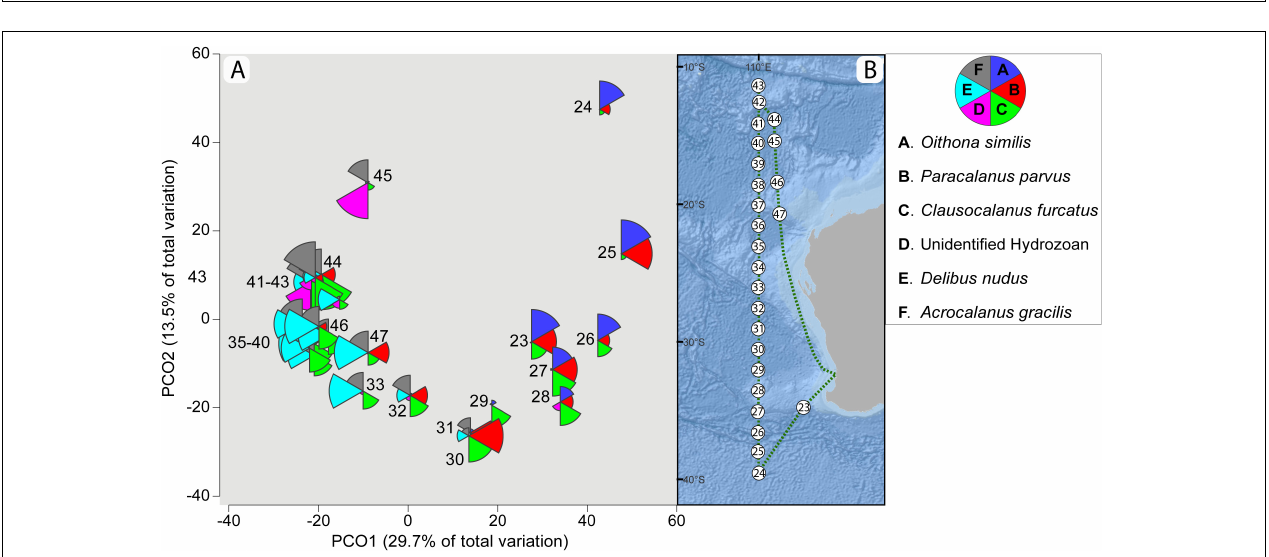
FIGURE 6 | Principal Coordinate Ordination (PCO) based on Bray Curtis similarities of square root transformed plankton (18S rRNA gene) metabarcoding data along a latitudinal transect in the Indian Ocean investigated during the Australian case study (A) with the corresponding sampling station numbers (23–47) as described in Table 1 and Figure 2 . (B) The color pie charts represent the relative prevalence [i.e., Amplicon Sequence Variants (ASVs) proportions] of the six most abundant taxa (at the species level; see